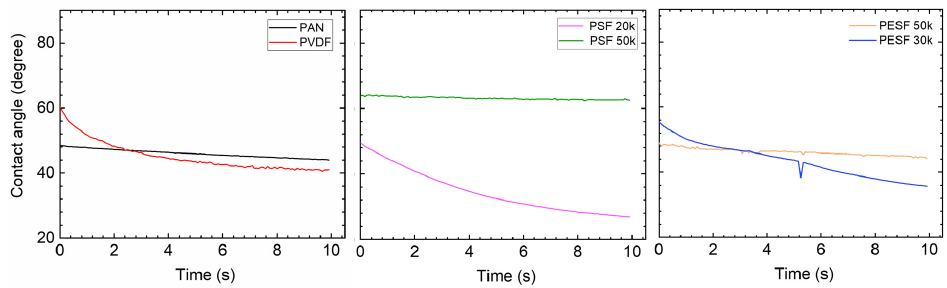
Figure 10. The CA of the 6 selected porous support coated with Pebax 1657.